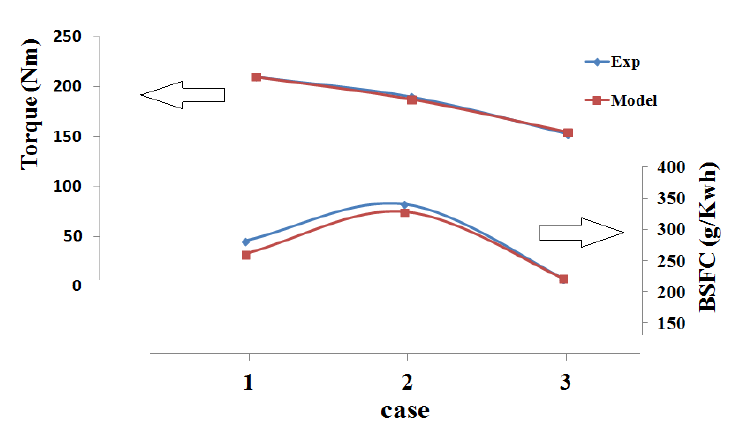
Figure 9. Torque and brake specific fuel consumption (BSFC) validation of the base engine model.